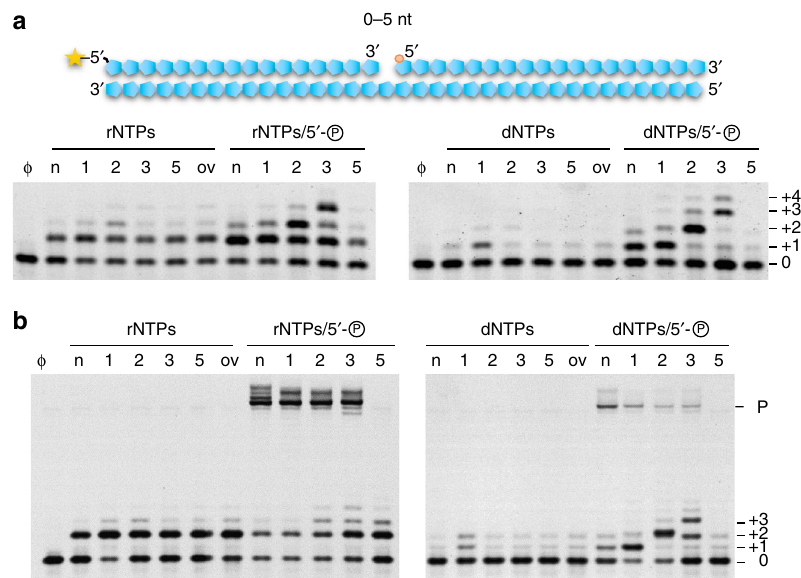
Fig. 3 Short gap- fi lling activity of Prim-PolC in complex with LigC1. a Prim-PolC prefers to insert rNTPs into short gaps. In primer extension assays, 30 nM of 5 ′ - fl uorescein labelled 36-mer containing a nick (n), a single-stranded gap of various length (indicated as numbers), with or without phosphorylation of the 5 ′ -end or lacking the 5 ′ -end strand thus forming an overhang (ov), was extended by Prim-PolC (300 nM) in the presence of a 250 µ M dNTPs or rNTPs mix for 5 min at 37 °C. b The preferred products from Prim-PolC gap- fi lling are ligatable. For gap fi lling and ligation, LigC1 (300 nM) was added to the primer extension reactions (same as a ) and were incubated for an extra 45 min at 37 °C to produce a repair product